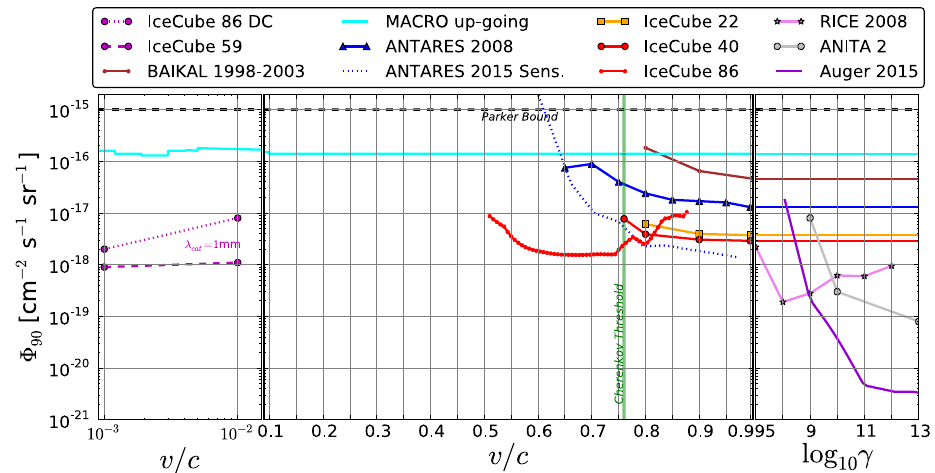
Fig. 37 Upper limits on the flux of magnetic monopoles as a function of the velocity of the monopole at the detector [329]. Shown are limits from IceCube [335,336,342], Baikal [340], ANTARES [343,344], RICE [345], ANITA [346] and Auger